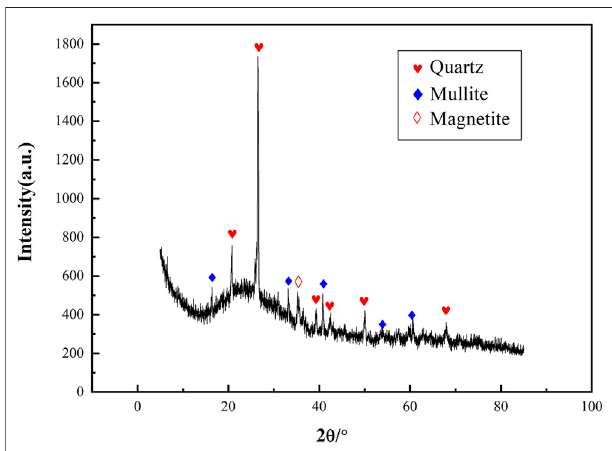
FIGURE 6 | Mineral composition of fl y ash.